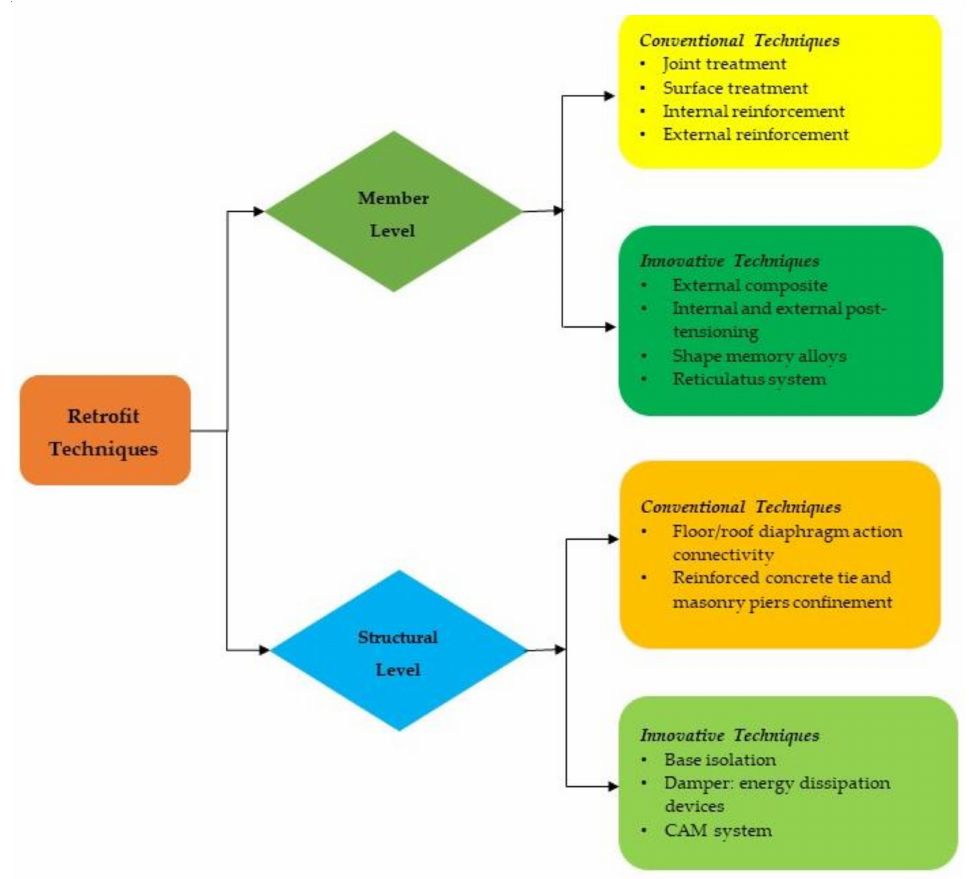
Figure 1. Classification of retrofit